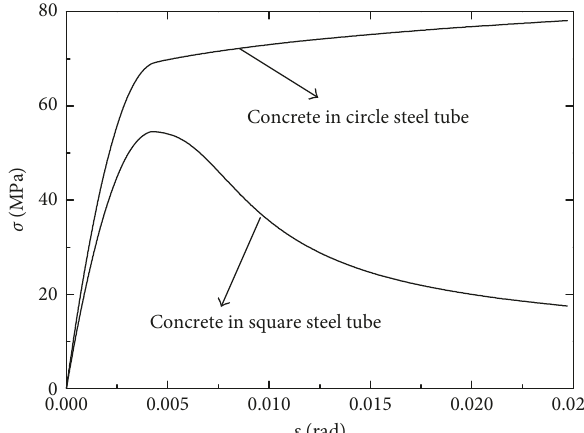
Figure 9: Compressive stress-strain curves of the core concrete.